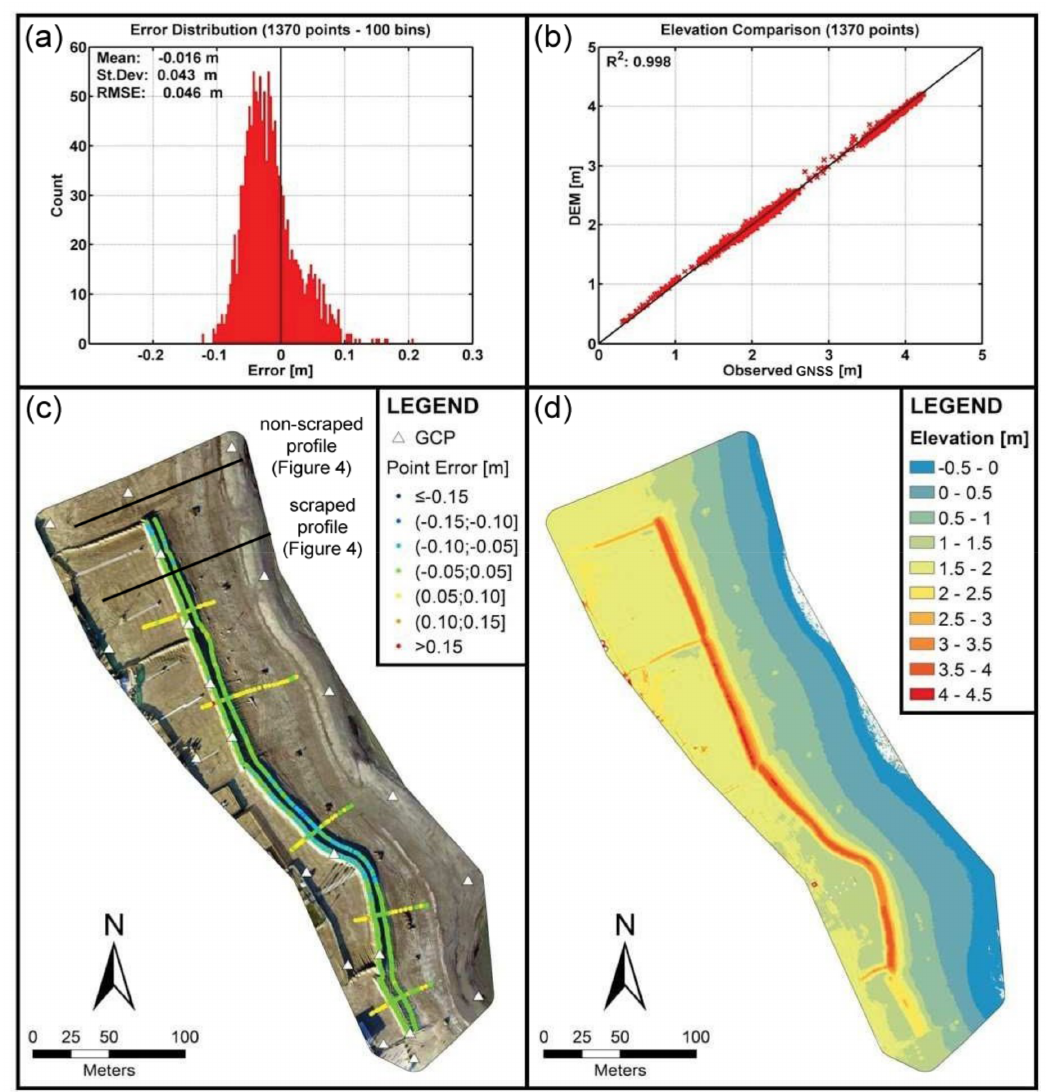
Figure 5. Error analysis for the survey implemented on the 21 December 2016: ( a ) distribution of the errors and synthetic descriptors; ( b ) correlation between the digital elevation model (DEM) and global navigation satellite system (GNSS) measurements; ( c ) orthophoto, spatial distribution and entity of the errors, position of the ground control points (GCPs) and the track of the profiles shown in Figure 4b; and ( d ) digital elevation